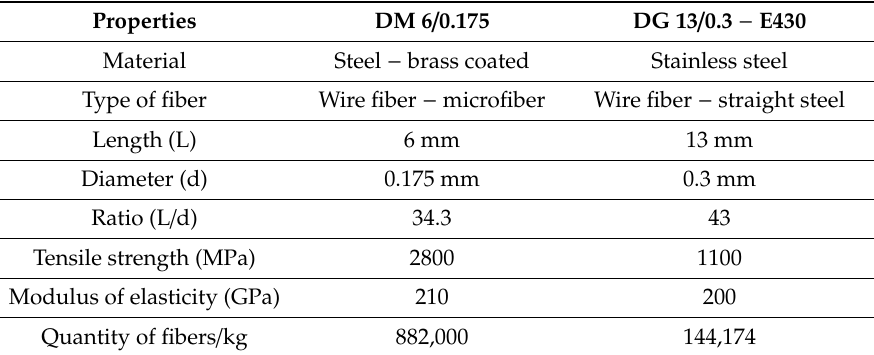
Table 3. Characteristic of used steel fibers.